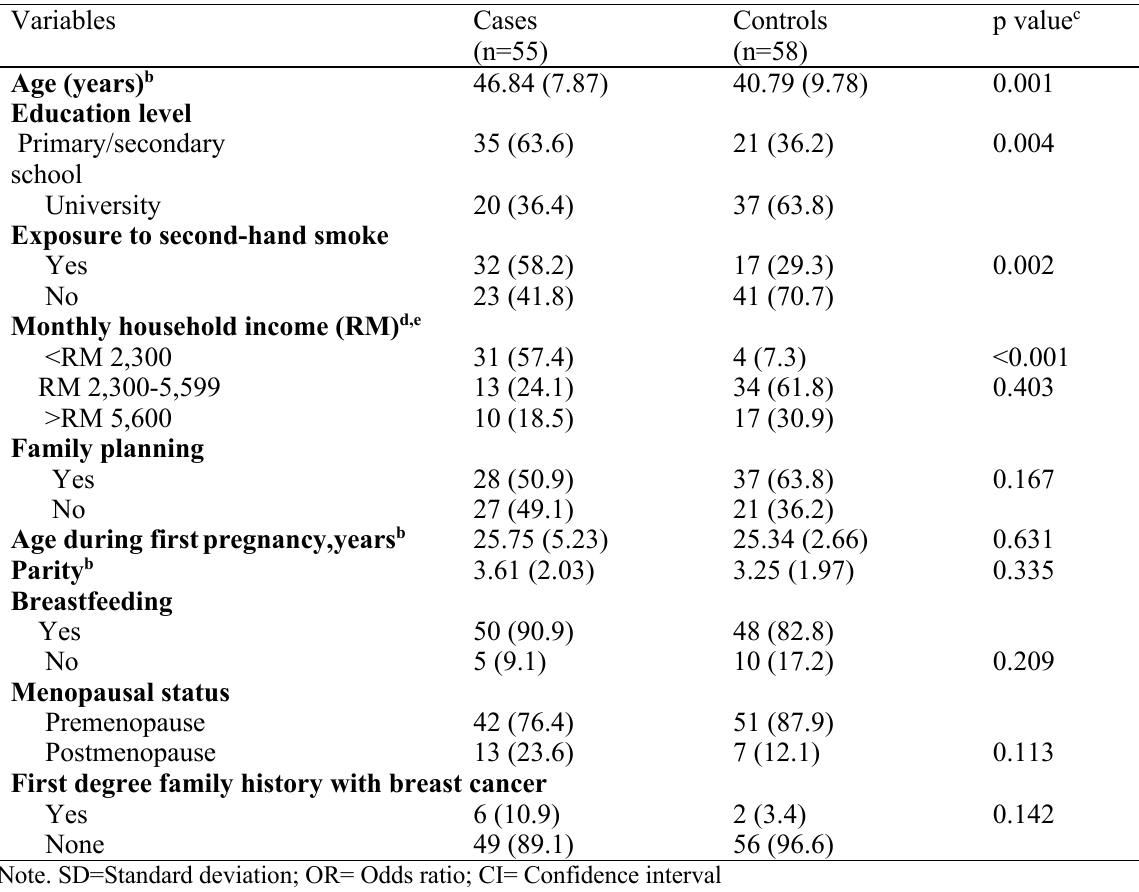
Table 1 Baseline characteristics of the respondents a